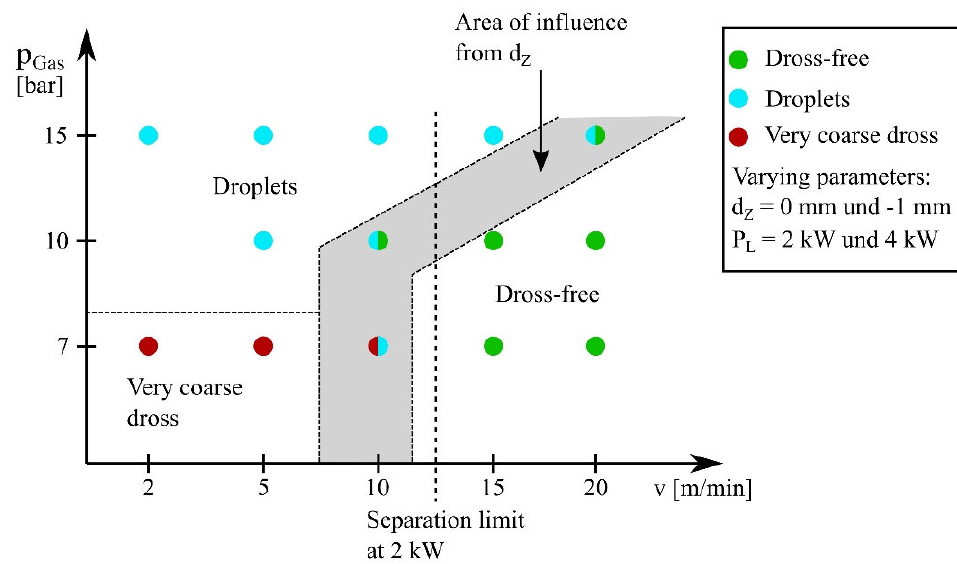
Figure 4. Influence of process parameters on the dross geometry with varying powers of 2 kW and 4 kW and focus positions of − 1 mm and 0 mm.